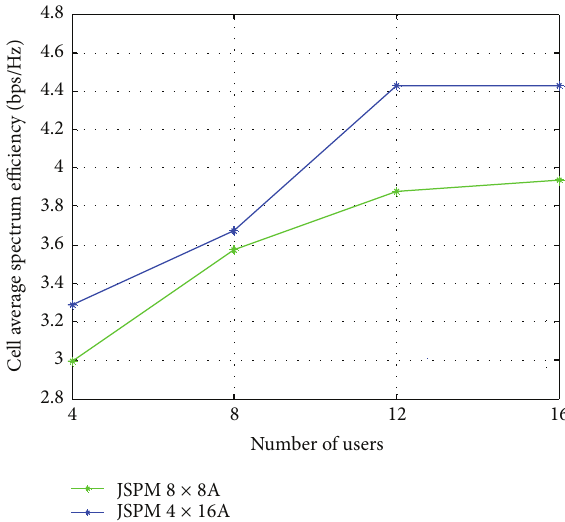
Figure 7: Cell average spectrum efficiency (SE) comparison with different user numbers per cell.